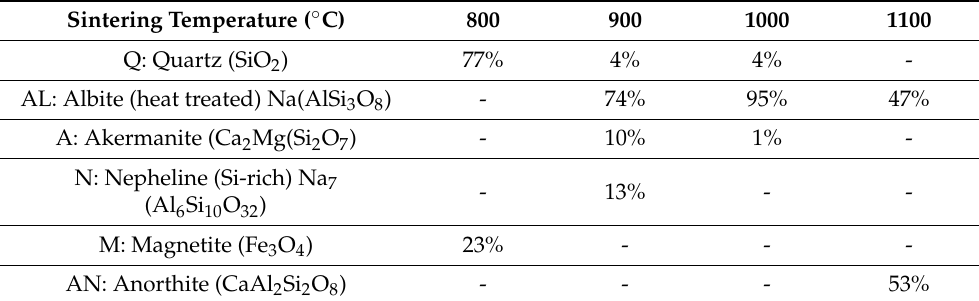
Figure 5. The phase transformation of sintered kaolin–GGBS geopolymer at different sintering temperatures ( a ) 800 ◦ C, ( b ) 900 ◦ C, ( c ) 1000 ◦ C, and ( d ) 1100 ◦ C. Table 2. Phase composition of sintered kaolin-GGBS